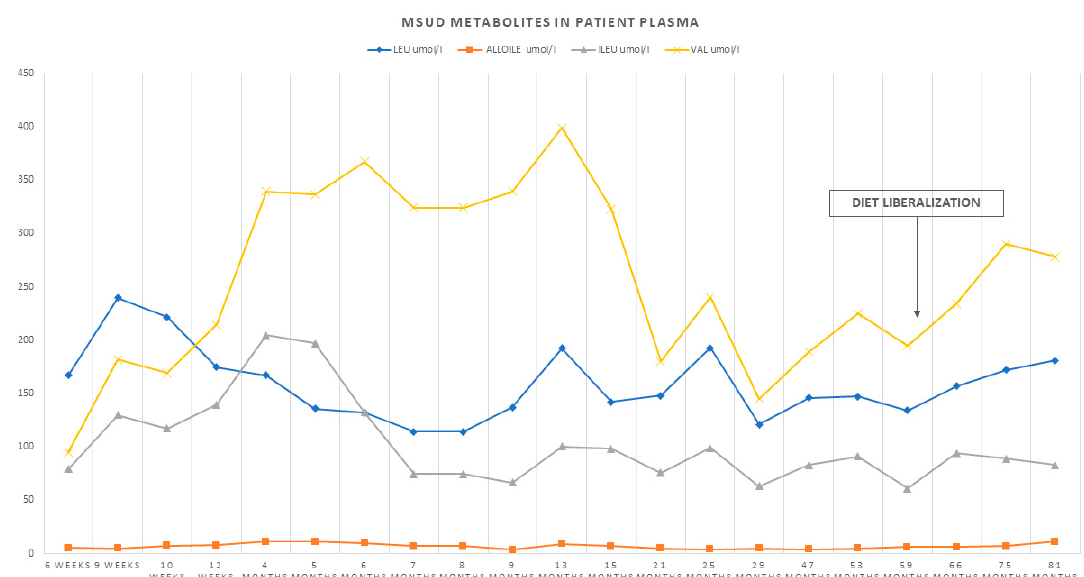
Figure 4. Graphical representation of the trend of BCAAs and alloisoleucine during follow-up and after protein intake liberalization.